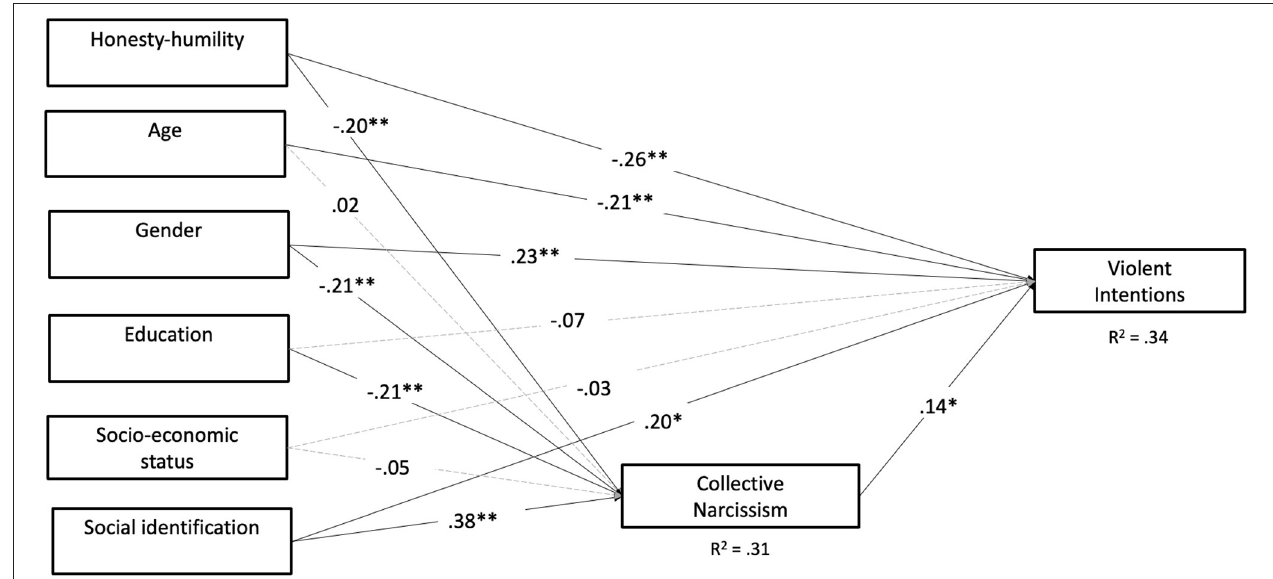
FIGURE 3 | Path model predicting violent intentions amongst soccer supporters controlling for demographic variables. Estimates are standardised estimates. * p < 0.05 and ** p < 0.01. Gender is coded: Women, 1 and Men, 2.